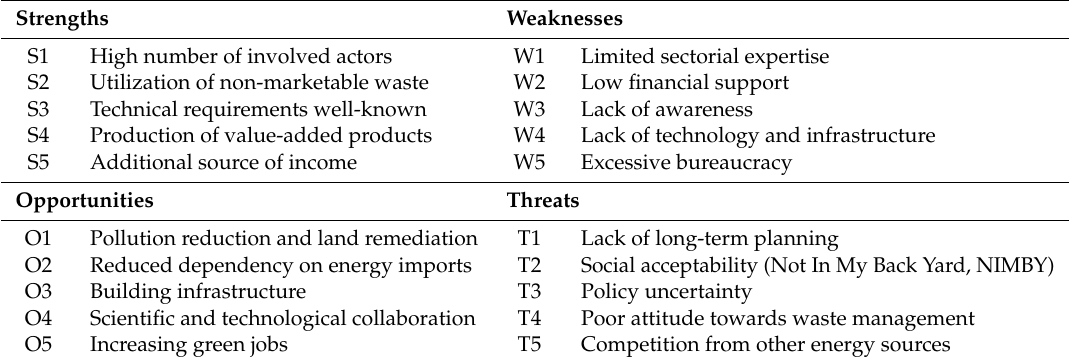
Table 5. Strengths, Weaknesses, Opportunities and Threats (SWOT) analysis of the tourism industry in the study area.